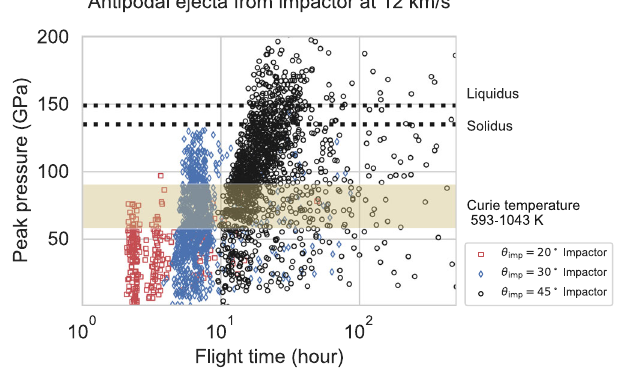
Fig. 3 Peak pressure of antipodal ejecta sourced from the impactor as a function of their fl ight time. Each symbol represents ejecta from 12 km/s impacts with different impact angles (see legends). Note that we only plot the antipodal ejecta located within 3° of the antipode. Horizontal beige bar (57 – 90 GPa) shows the corresponding pressure of the Curie temperature of pyrrhotite (593 K) and iron (1043 K) based on the equation of state of dunite 57 . We take pyrrhotite as a lower limit of Curie Temperature. Pyrrhotite is found in carbonaceous chondrites, possible impactors, as a remanence carrier 66 . Horizontal black dashed lines denote solidus (incipient melting) and liquidus (complete melting) of dunite 67 .